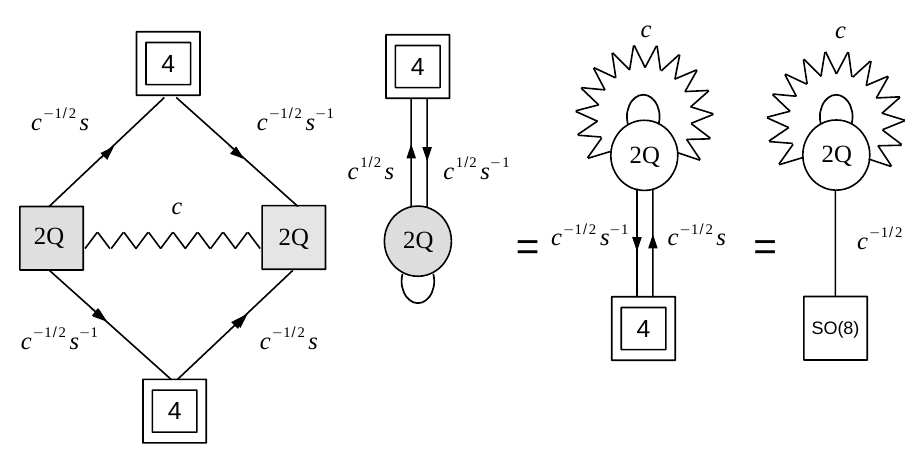
Figure 14: Self-gluing of the minimal tube yields the torus with flux (cid:1) (cid:0) 1 , 1 , 1 , 1 , 1 , 1 , 1 , 1 . The shaded nodes indicate the gauging which identifies 2 2 2 2 2 2 2 2